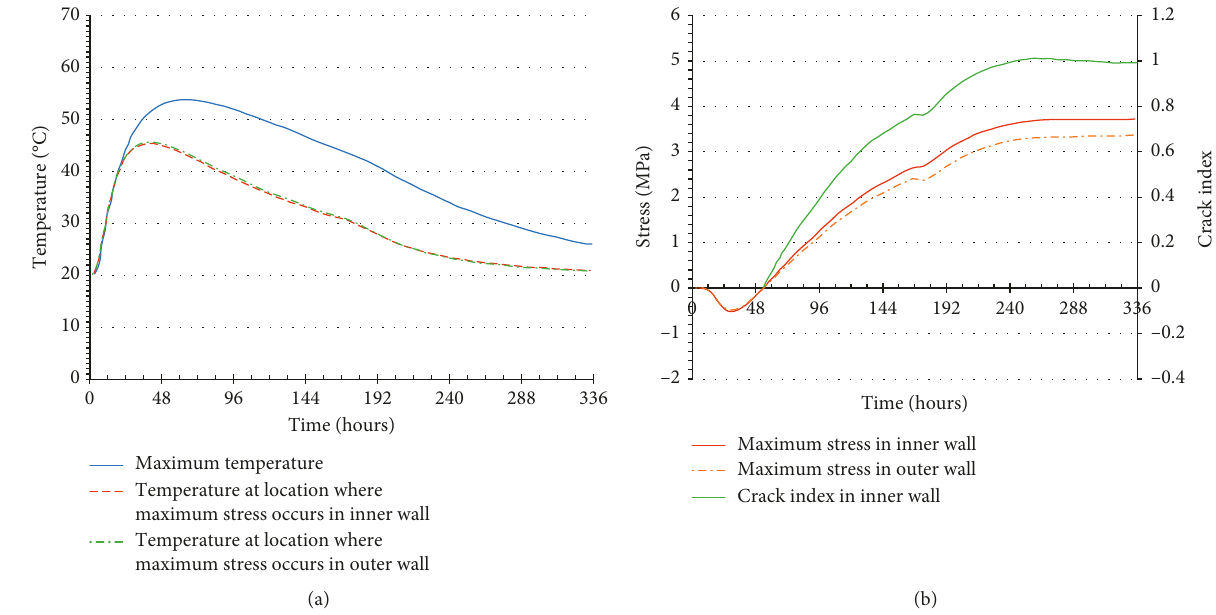
Figure 11: Calculated temperature (a) and stress (b) developments of 40% BFS